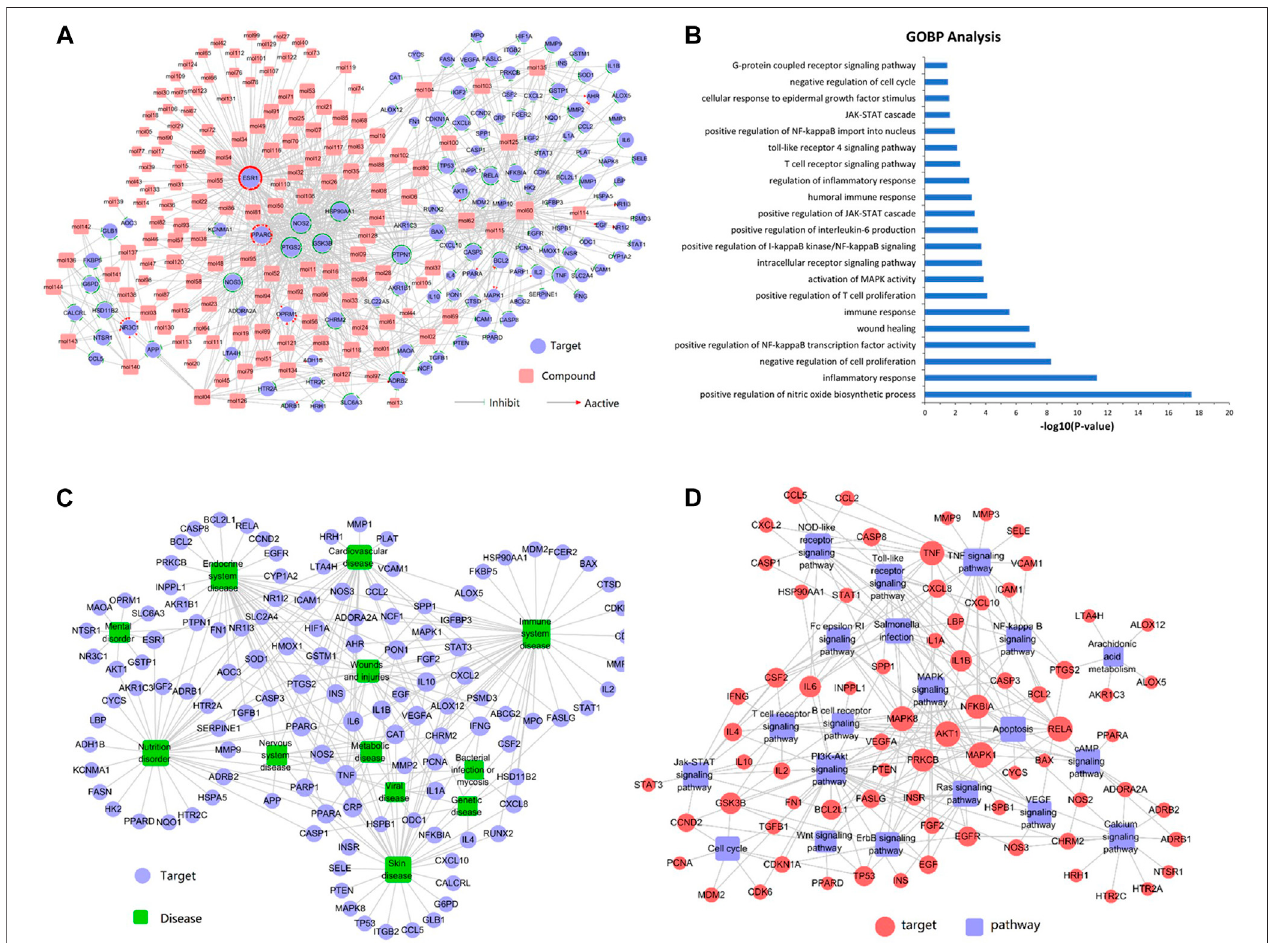
FIGURE 1 | (A) Compound-target network analysis. A compound and a target are linked if the target protein is hit by the corresponding compound. Node size is proportional to its degree. The pink square represents the compounds and the purple circle represents the targets. (B) GO enrichment analysis of the predicted protein targets. The top 21 enriched biological processes related to the targets are shown ( p < 0.05). (C) Target-disease network. Target proteins are linked to their corresponding diseases and those diseases are linked to the corresponding disease categories they belong to. The purple circle represents the target and the greensquarerepresentsthedisease. (D) Thetarget-pathwaynetworkwasconstructedbylinkingactivecompoundstotheirrelatedpathways.Nodesizeisrelatedtothe degree. The red circle represents the target and the purple square represents the